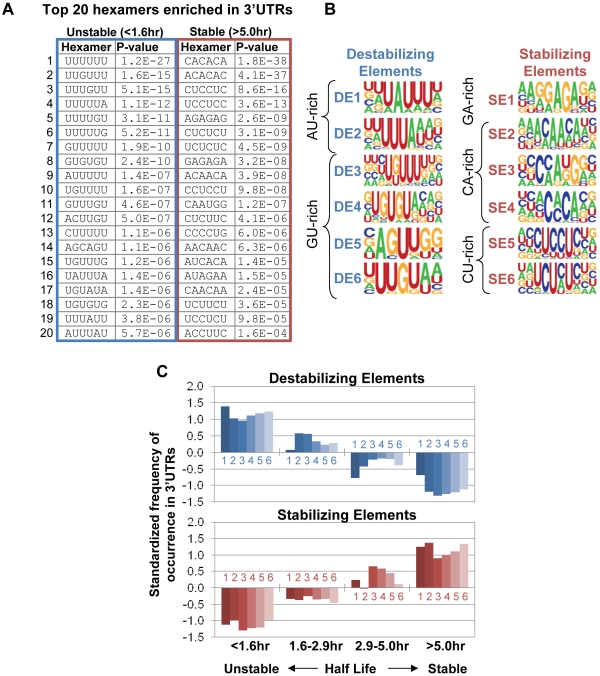
Destabilizing and stabilizing elements in 3′UTRs have combinatorial effects on mRNA stability.(A) Top 20 ranked hexamers significantly enriched in the 3′UTRs of mRNAs with short and long half-lives. P-values were derived from Fisher's exact test. (B) Destabilizing and stabilizing elements (DEs and SEs) were derived by grouping significant hexamers (see Figure S1), and presented as sequence logos. (C) DEs and SEs have different frequencies of occurrence in 3′UTRs of mRNAs with different half-lives. mRNAs were divided into 4 groups based on their half life (shown in Figure 1B), i.e. 0–10%, 10–50%, 50–90%, and 90–100%. For each element, the frequencies of occurrence were standardized across the 4 groups by calculating (x-mean)/sd, where x is frequency of occurrence for an element in a group, and mean and sd are mean and standard deviation of frequencies of occurrence for the element in all groups.